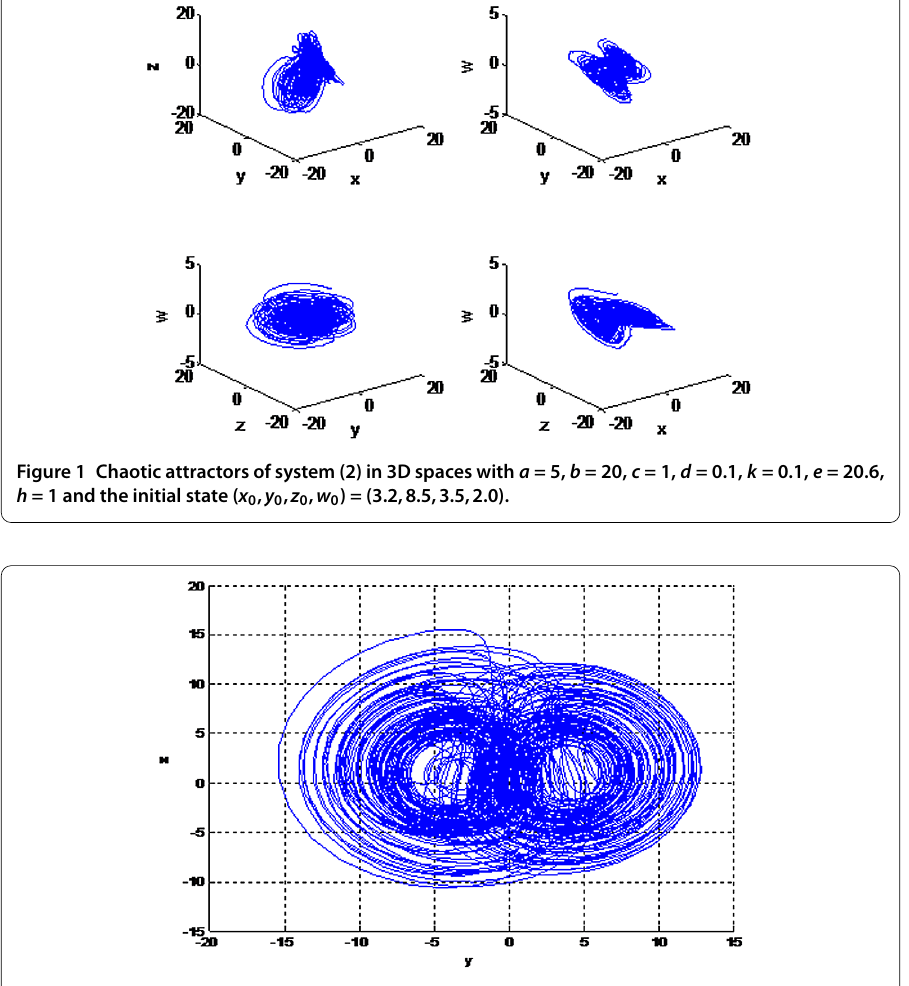
When u  = ., u  = ., q  = ., q  = ., ε  = ., ε  = . with the initial state ( x  (), x  (), w  (), w  ()) = (.,.,.,.), system () has a chaotic attractor,